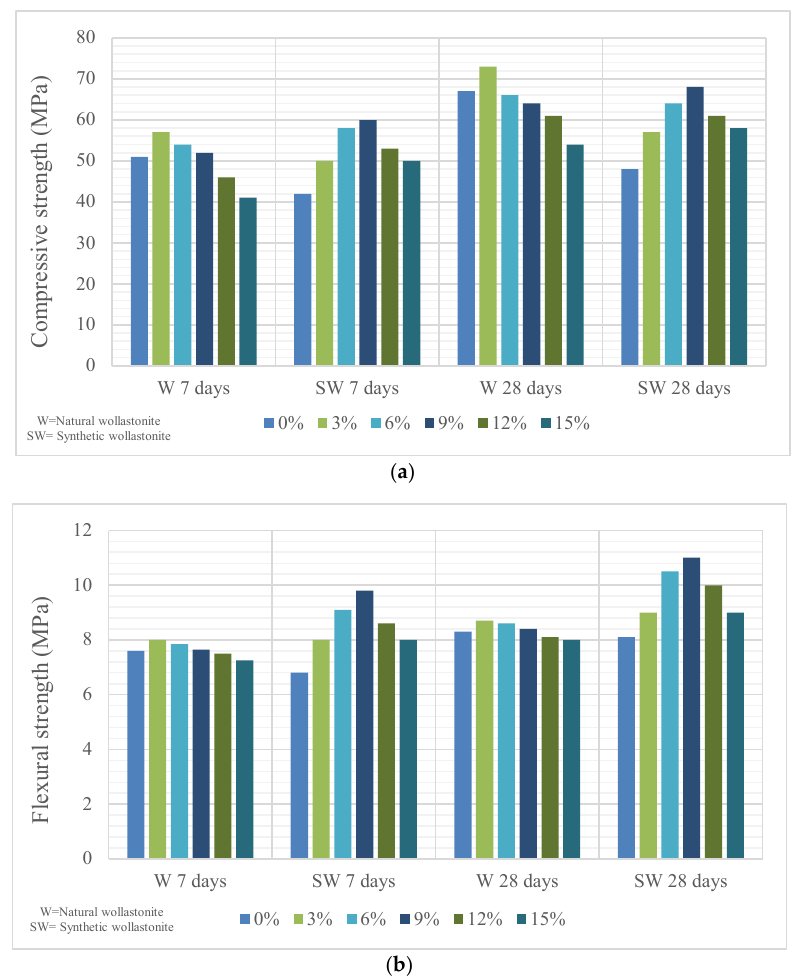
Figure 2. Fracture toughness of wollastonite content based on Ref. [34].